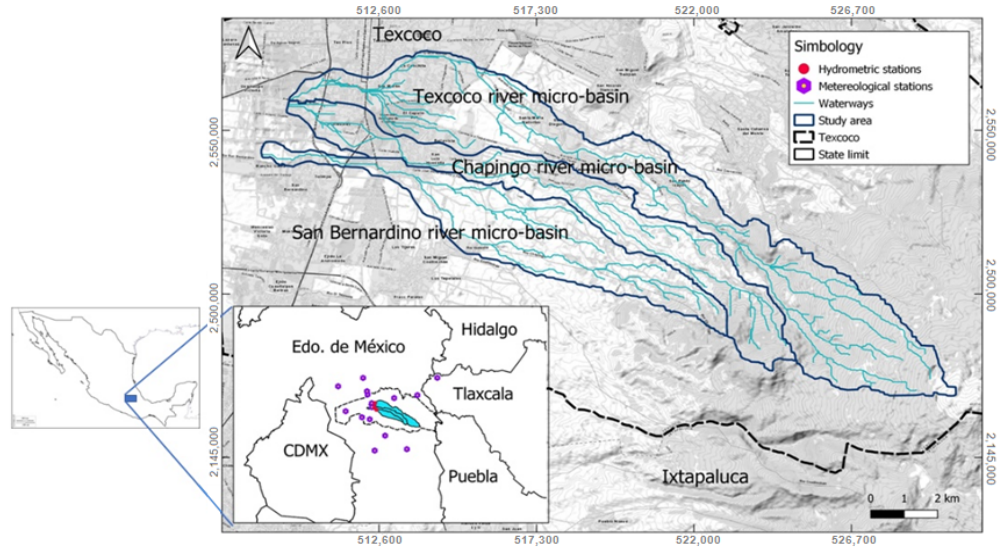
Figure 1. Geographic location of the study area.